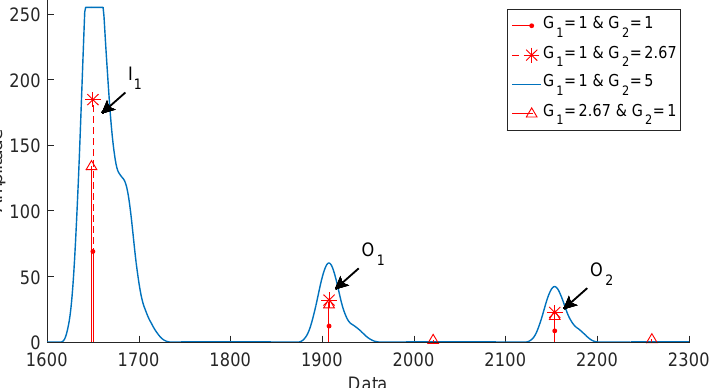
Figure 13. Analysis of the effects on the signal processing when the gains of the bandpass ( G 1 ) and lowpass ( G 2 ) filters change; at an excitation voltage of 100 V and a d SO distance of 15